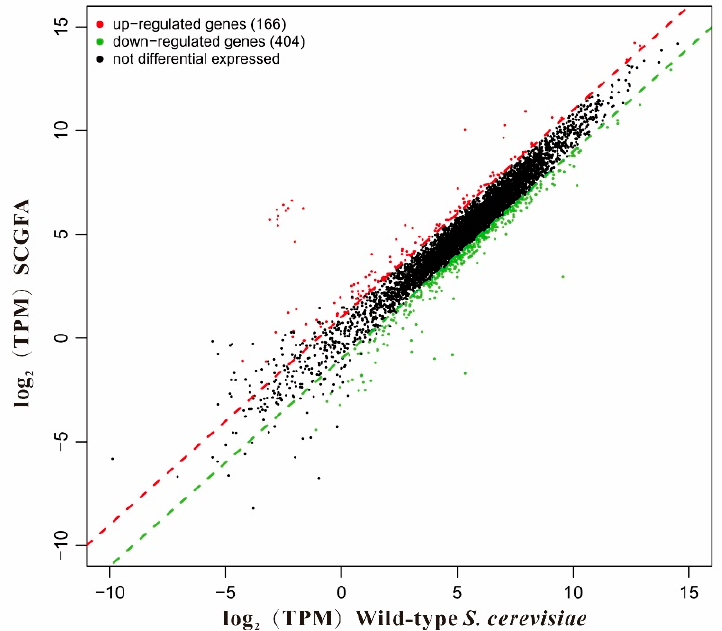
Figure 12. Log 2 (TPM) values between the SCGFA and wild-type strain. The red, green, and black points represented up-regulated, down-regulated, and non-differential genes, respectively.